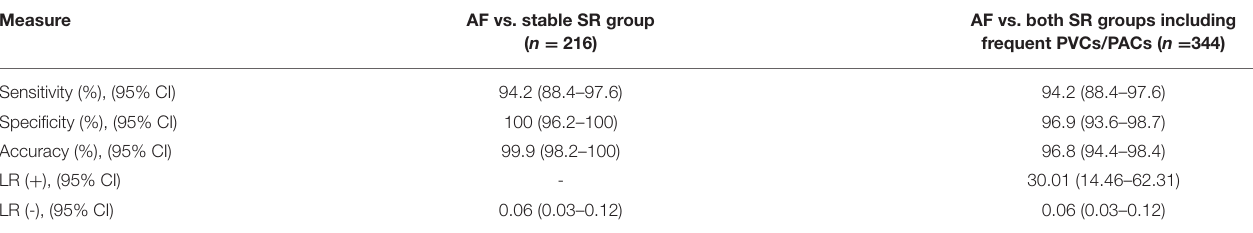
TABLE 2 | Diagnostic measures of automated PPG-based algorithm for AF detection. Measure AF vs. stable SR group